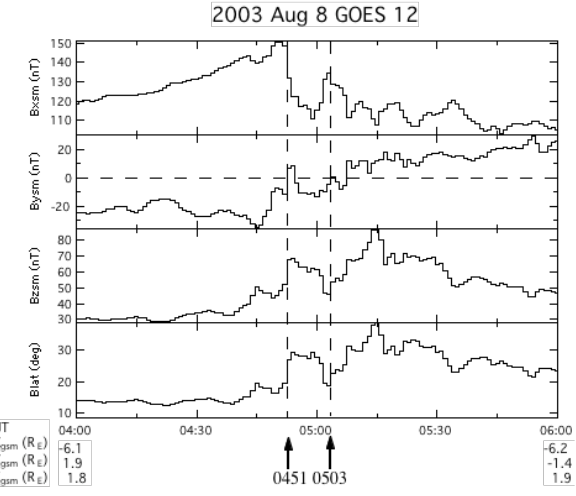
Figure 6 Fig. 6. The magnetic field measurements from the GOES 12 satel-